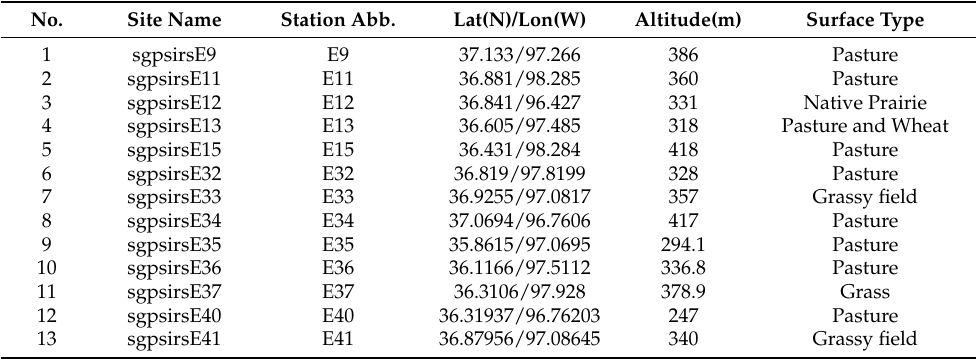
Table 3. Geolocation and surface type of the ARM